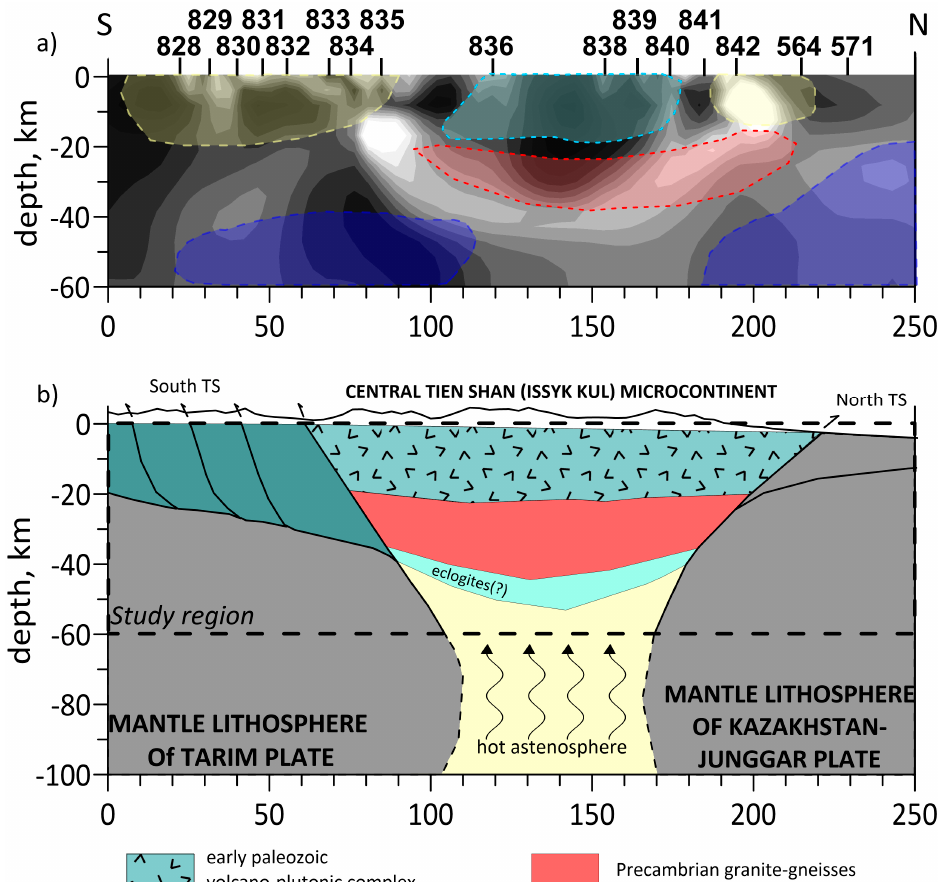
Figure 11. The upper section ( a ) demonstrates a juxtaposition of the MTS and ST results obtained at the Kekemeren profile (profile location is shown in Figure 1). The lower section ( b ) is the generalized interpretation scheme characterizing the depth structure of the Tien Shan.